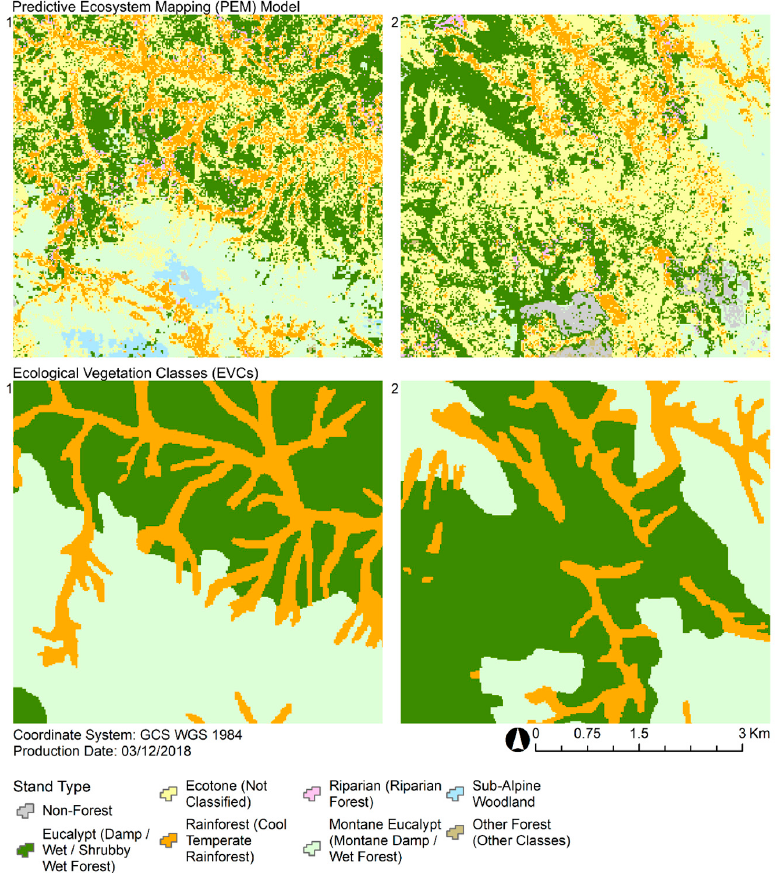
Figure 7. Stand type classifications for the predictive ecosystem mapping (PEM) model and ecological vegetation classes (EVCs) across two 5 km × 5 km extents (see Figure 1). EVCs are listed in parenthesis where they differ from PEM classes.